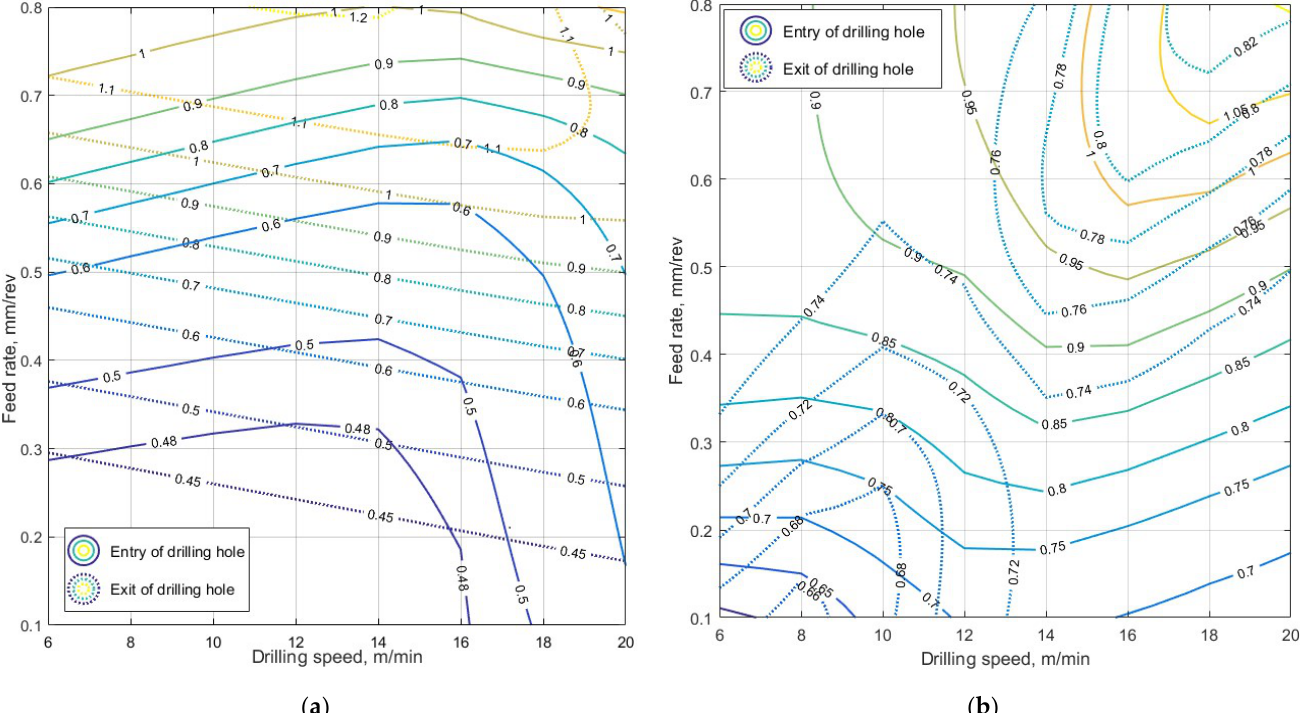
Figure 9. Superimposed level lines maps of predicted delaminations at the entry (solid lines) and at the exit (dashed lines) from the hole of the double-point angle drill ( a ) and the dagger drill ( b ).